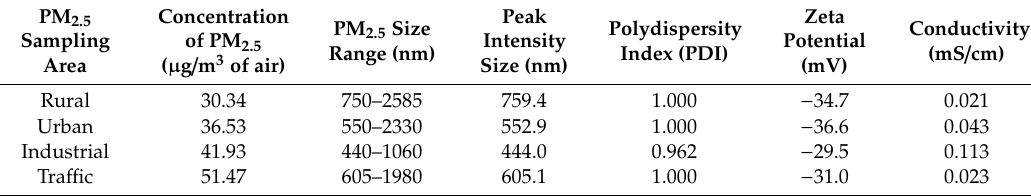
Table 3. Characteristics of fine particulate matter (PM 2.5 ) samples.